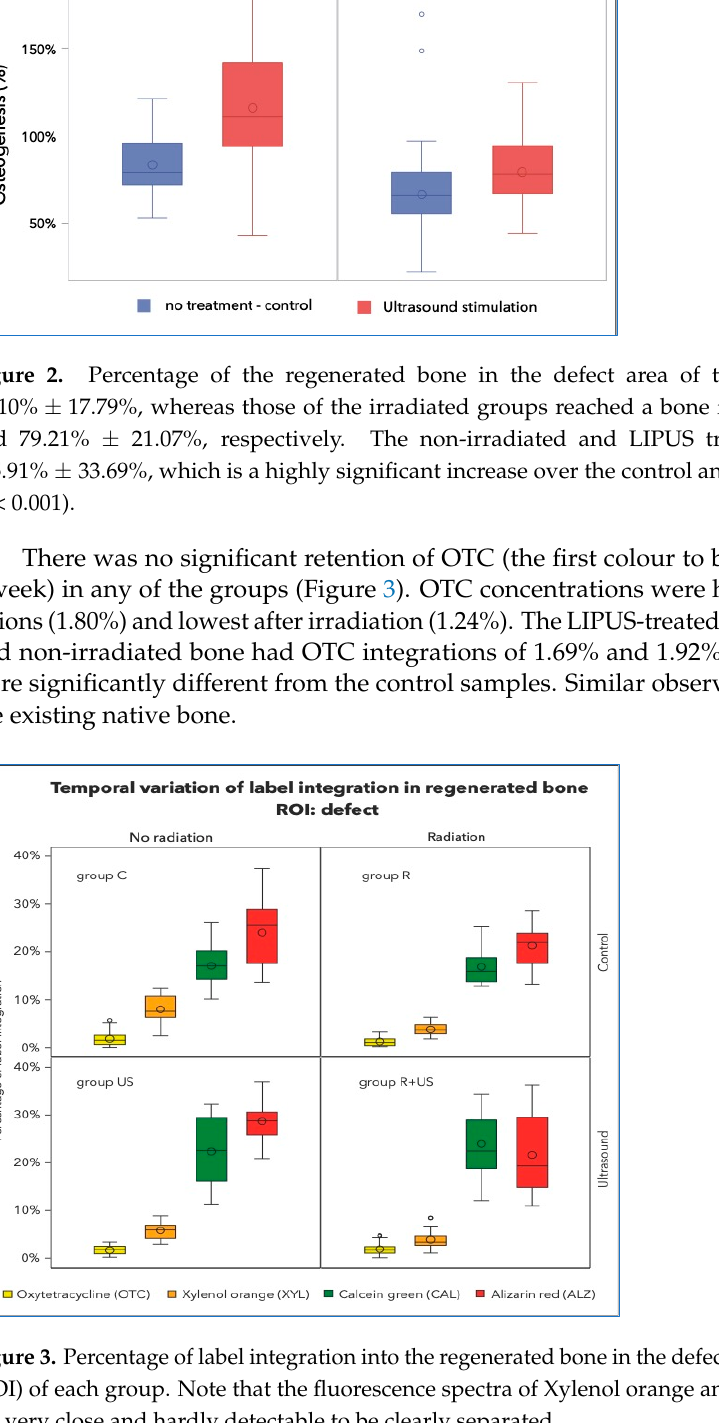
and ALZ could not be completely excluded (Figure